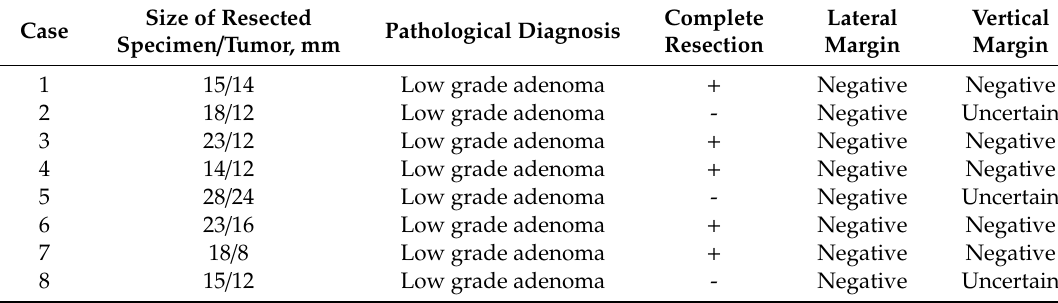
Table 2. Pathological